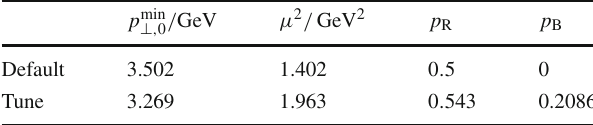
Table 1 Results of the parameter values from the tuning procedure that resulted in the smallest χ 2 / N dof value for energy compared with the default tune from Herwig